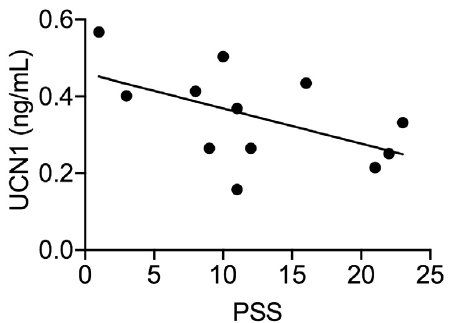
Figure 6. A scatterplot of the correlation between perceived stress score (PSS) and placental UCN1 levels. Analysis revealed that placental UCN1 levels were negatively correlated with PSS scores (r = 0.531, p = 0.07). Higher PSS scores indicate higher levels of stress experienced during the third trimester of pregnancy. Nulliparous women (n = 12) were recruited at the University of California San Francisco (UCSF) Mission Bay Hospital under UCSF’s institutional review board protocol # 16-10957. All women carried to term and completed PSS questionnaires between 37 and 40 weeks of gestation. Placentae were collected after delivery, and UCN1 levels were measured using ELISA.